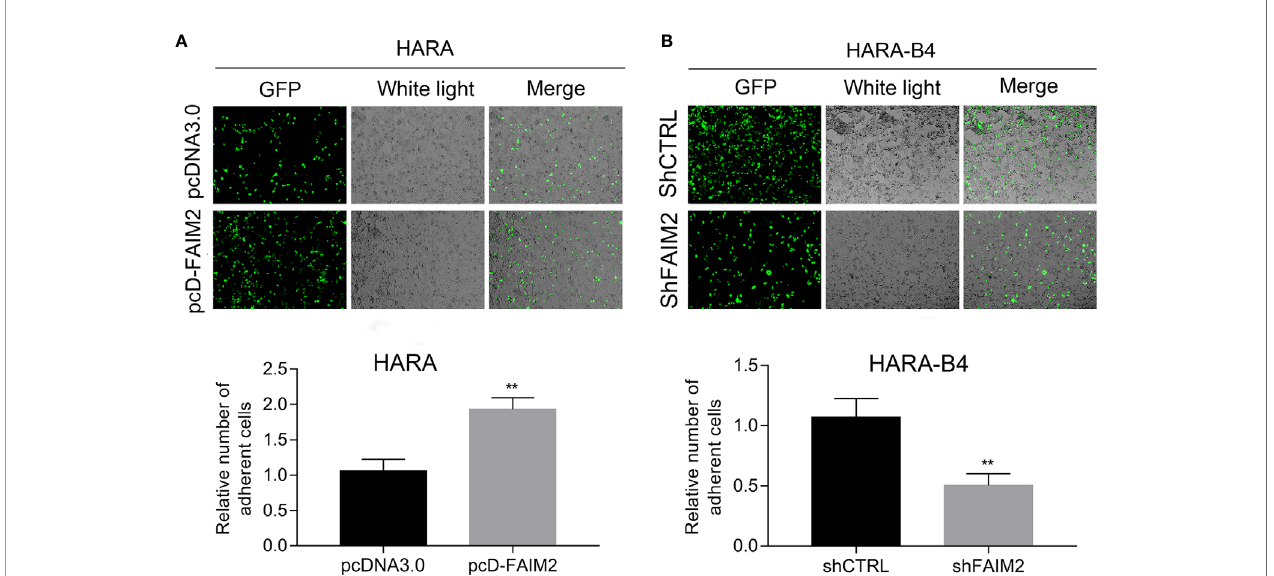
FIGURE 5 | FAIM2 was related to the ability of HARA and HARA-B4 cells to adhere to osteocytes. (A) Following pcDNA3.0 or pcD-FAIM2 transfection, the ability of HARA cells to adhere to MC3T3E1 cells (cells were subjected to induction of osteoblast differentiation) was evaluated. (B) Following shCTRL or shFAIM2 transfection, the ability of HARA-B4 cells to adhere to MC3T3E1 cells (cells were subjected to induction of osteoblast differentiation) was evaluated. P < 0.01, ** vs. the pcDNA3.0 or shCTRL